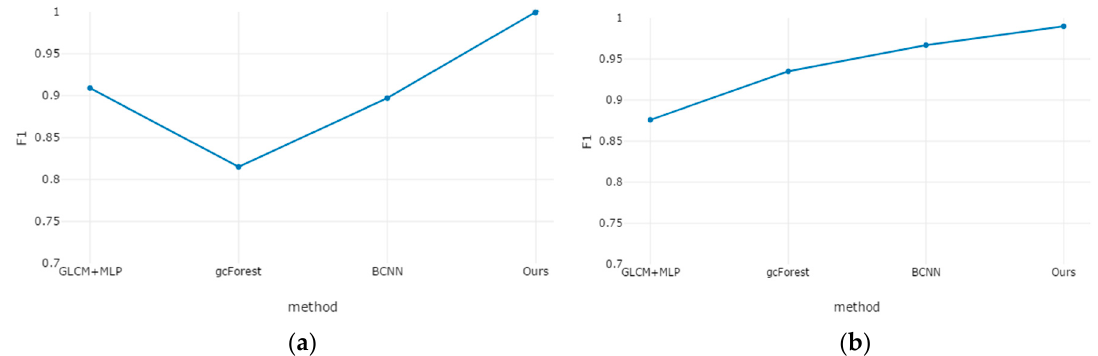
Figure 12. Comparison of F 1 curve obtained from four methods. ( a ) Diode glass bulb surface defect dataset; ( b ) Magnetic powder surface defect dataset.